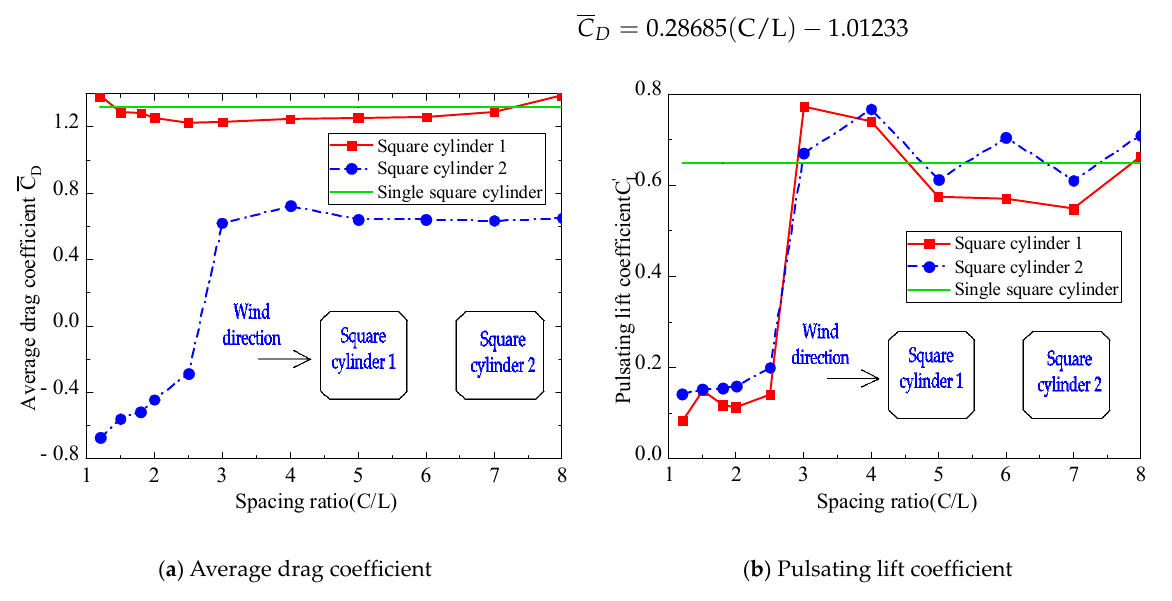
Figure 8. Variation curve of aerodynamic coefficient of tandem square cylinder with spacing ratio .